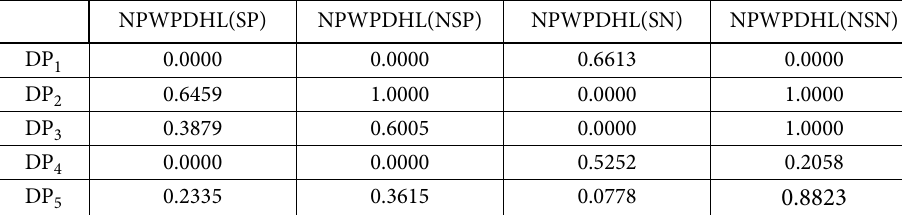
Table 19. NPWPDHL(SP/NSP) and NPWPDHL(SN/NSN) matrix NPWPDHL(SP)